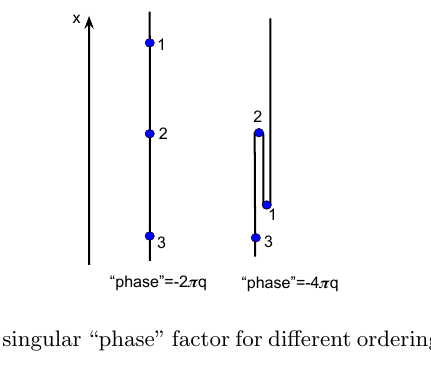
Figure 3 . The singular \phase" for di(cid:11)erent ordering and the geometric representation of the prop-